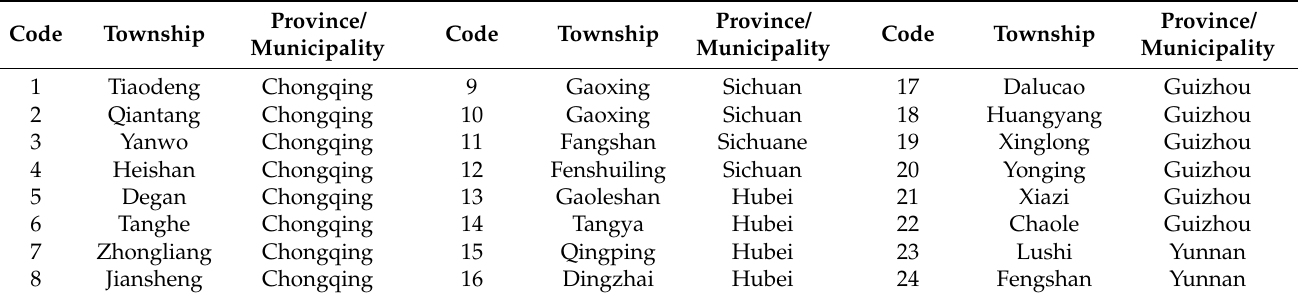
Table 4. The townships for on-site